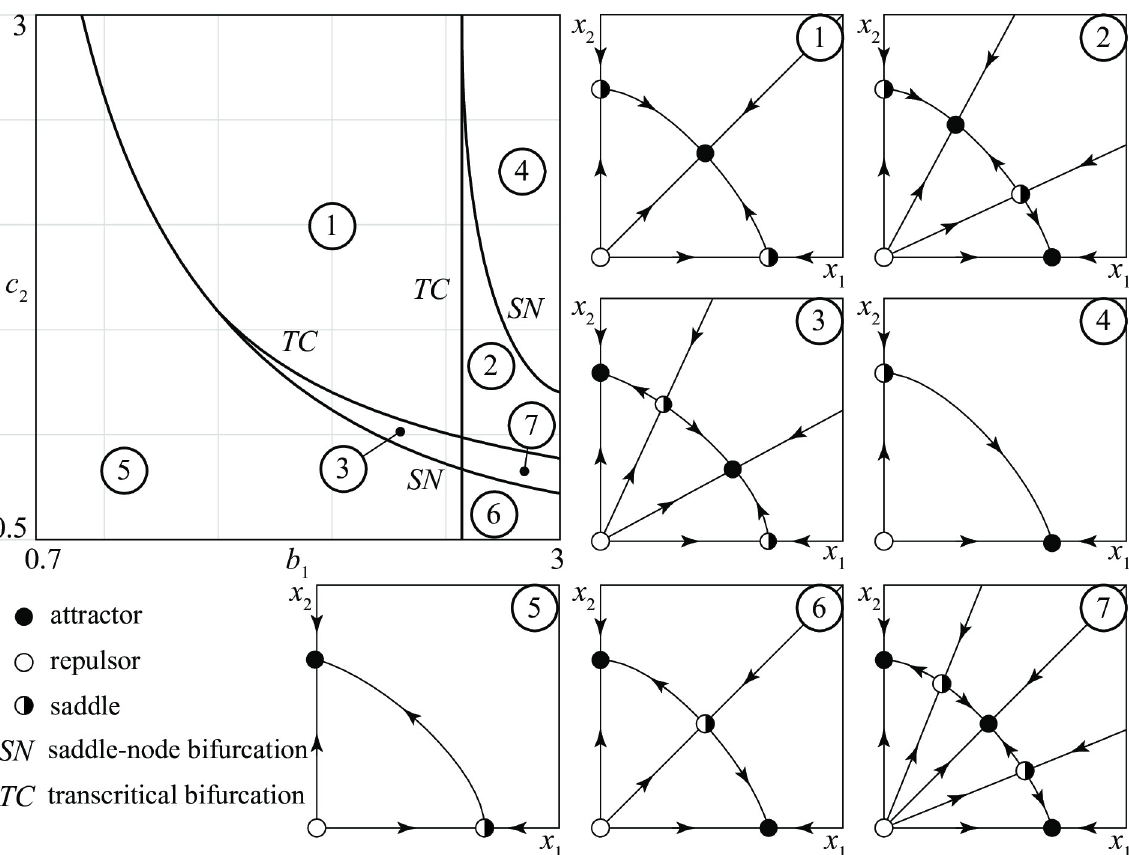
Fig 3. Example of a bifurcation diagram of a D—D